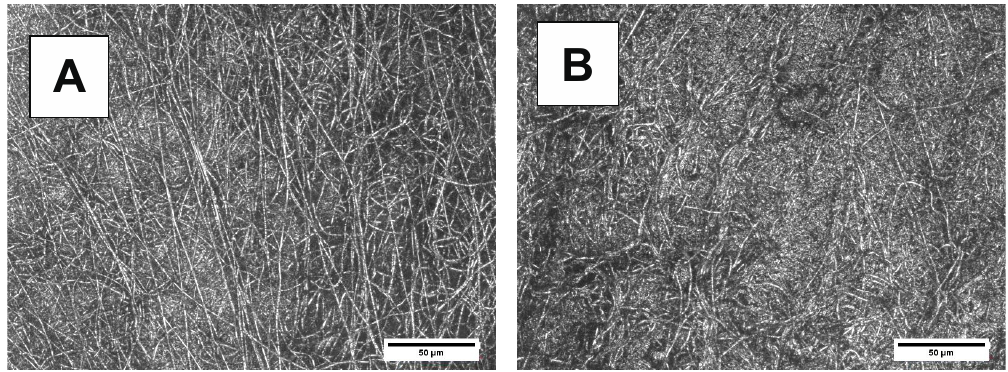
Figure 14. LSM micrographs of PBS DLS 70:30 electrospun fibers ( A ) before and ( B ) after 24 days of degradation.